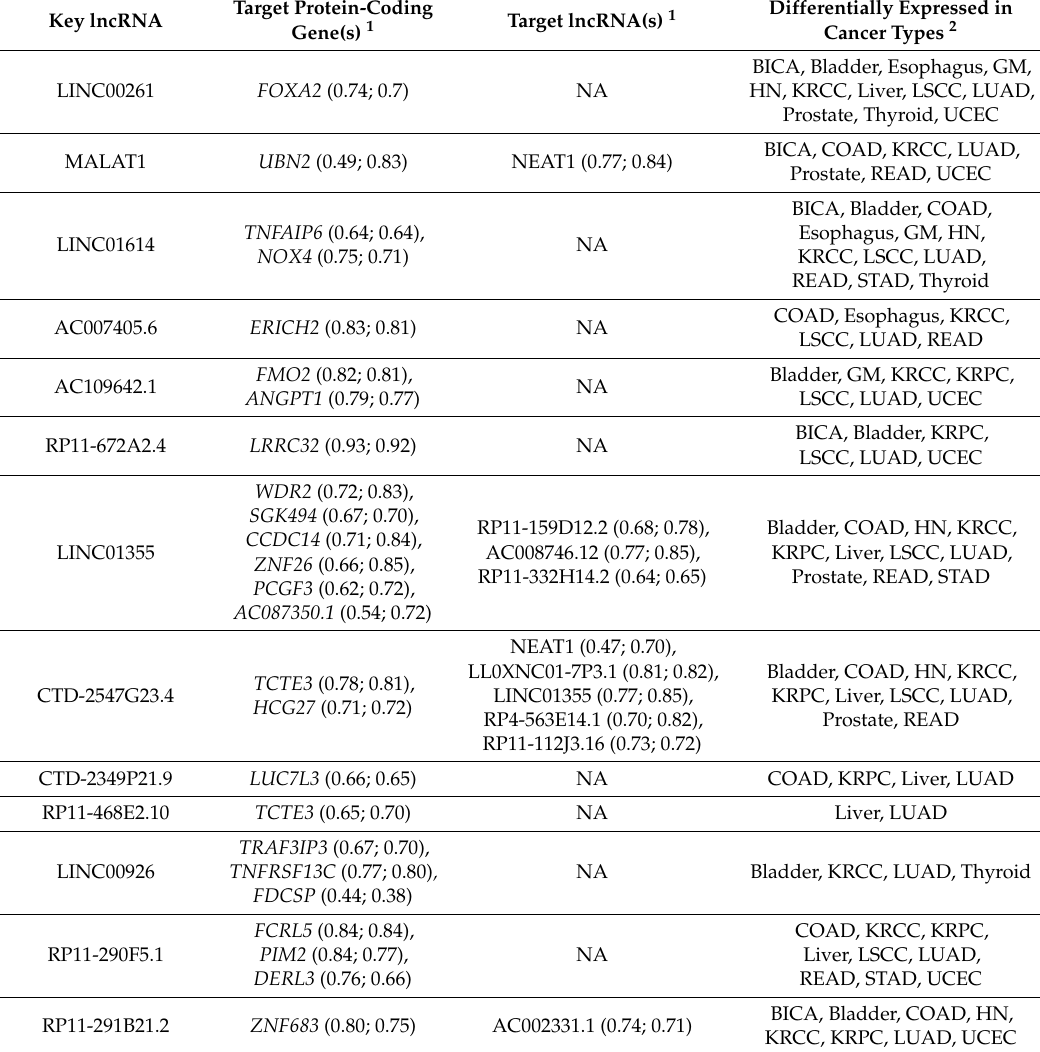
Table 1. Key regulatory long non-coding RNAs (lncRNAs), their corresponding downstream target protein-coding genes and lncRNAs, and the cancer types in which the key lncRNAs are differentially